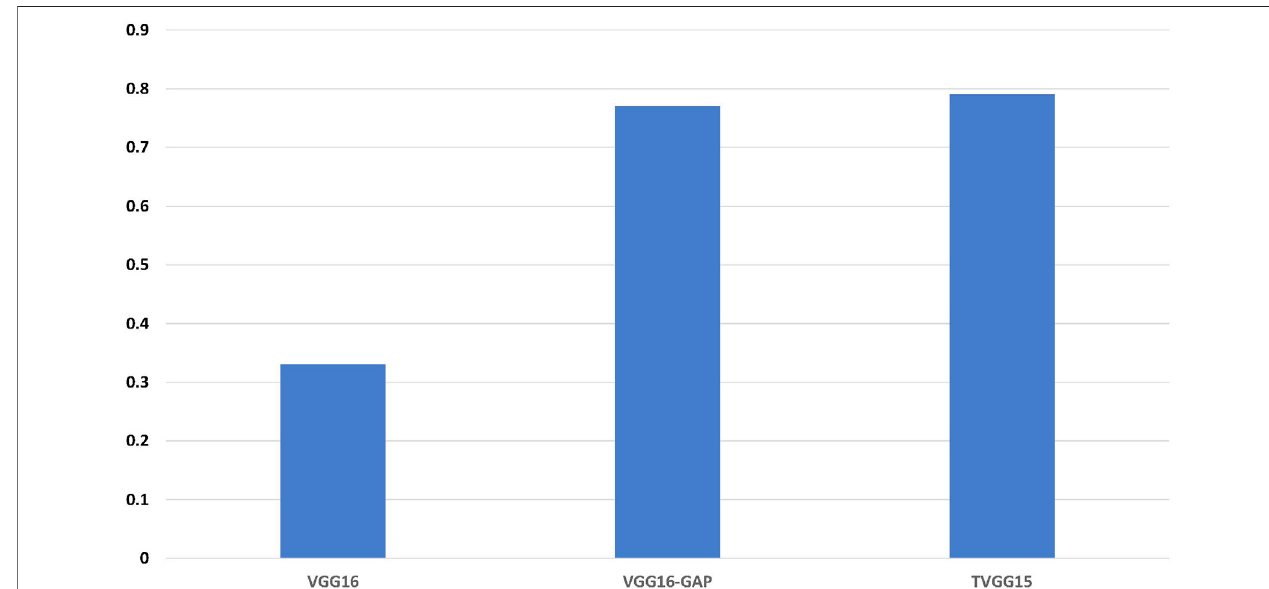
FIGURE 6 | Identi fi cation accuracy across all models.